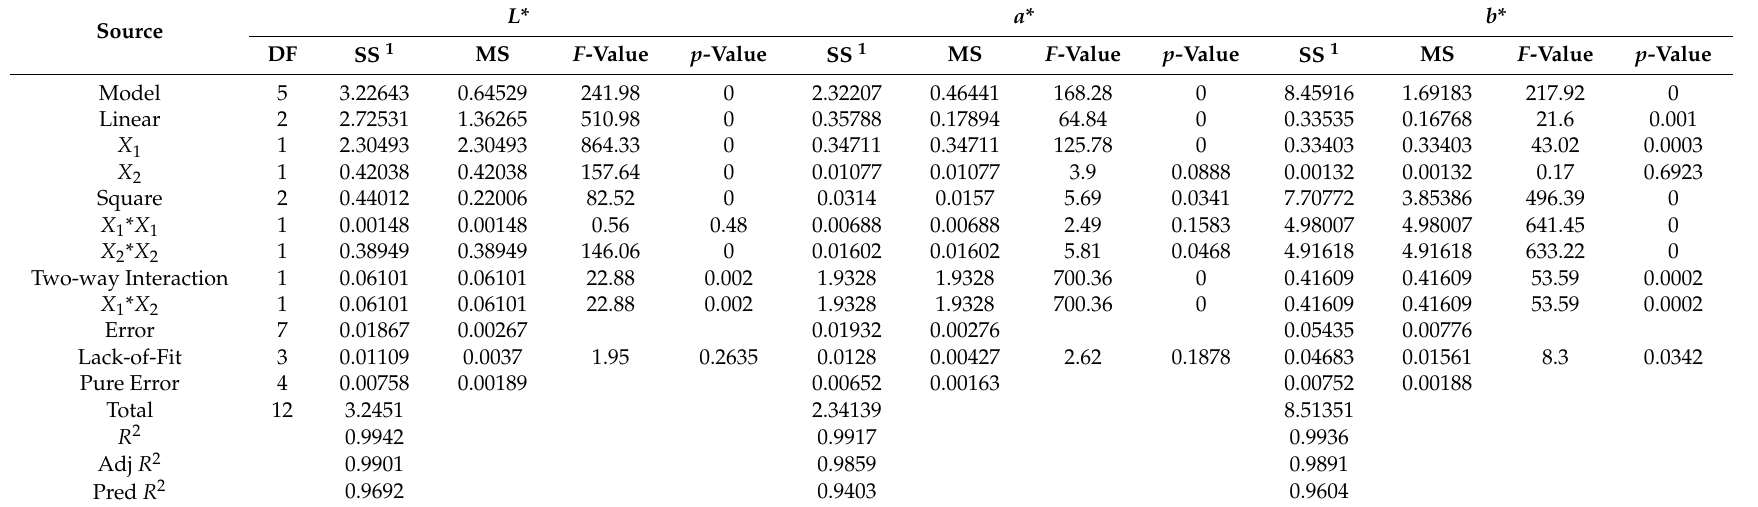
Table 5. Analysis of variance (ANOVA) of responses for L *, a *, and b *